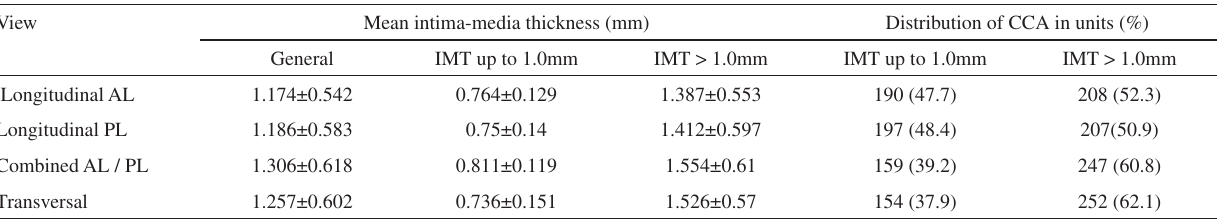
Table 1 - General measurement data showing mean values of intima-media thickness (IMT) and the distribution of common carotid arteries (CCA) divided by angle of view and groups of normal and thickened vessels. Combined views represent the thickest measurement obtained from the two longitudinal views View